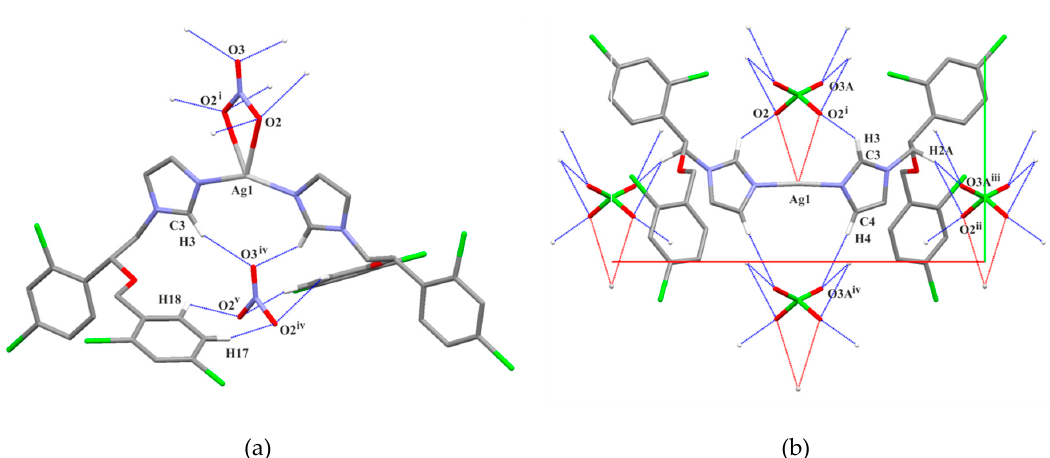
Figure 4. A scheme C–H ··· O of hydrogen bonds (blue dotted) between cations and anions of 1 ( a ) and 2 ( b ). Red dotted show weak Ag ··· O contacts between cations and anions of 2 ( b ). In both cases, hydrogen atoms not involved in H-bonds are omitted for clarity. Symmetry codes for 1 : (i) 1 − x , y , ½ − z ; (iv) x , − 1 + y , z ; (v) 1 − x , − 1 + y , ½ − z . Symmetry codes for 2 : (i) 1 − x , y , ½ − z ; (ii) − ½ + x , − ½ + y , z ;